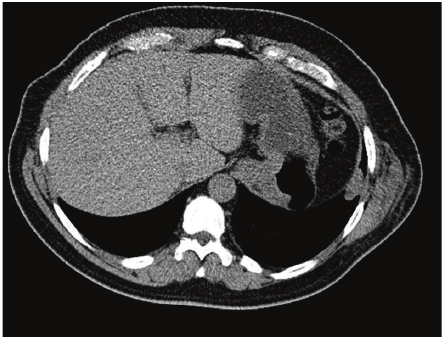
Figure 3: Chest CT-scan shows a 1.8cm left lower lobe nodule.